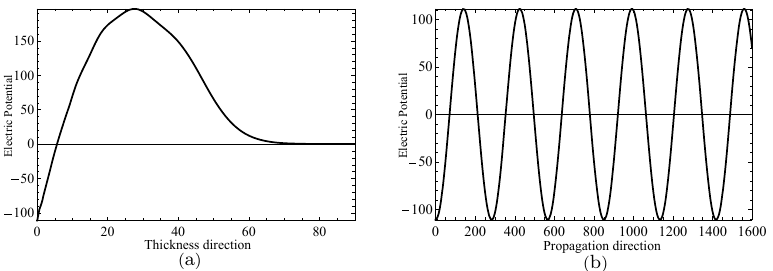
Figure 11. Electric potential distributions for thickness direction in ( a ) and propagation direction in ( b ) when f = 24.10 Hz, ξ =